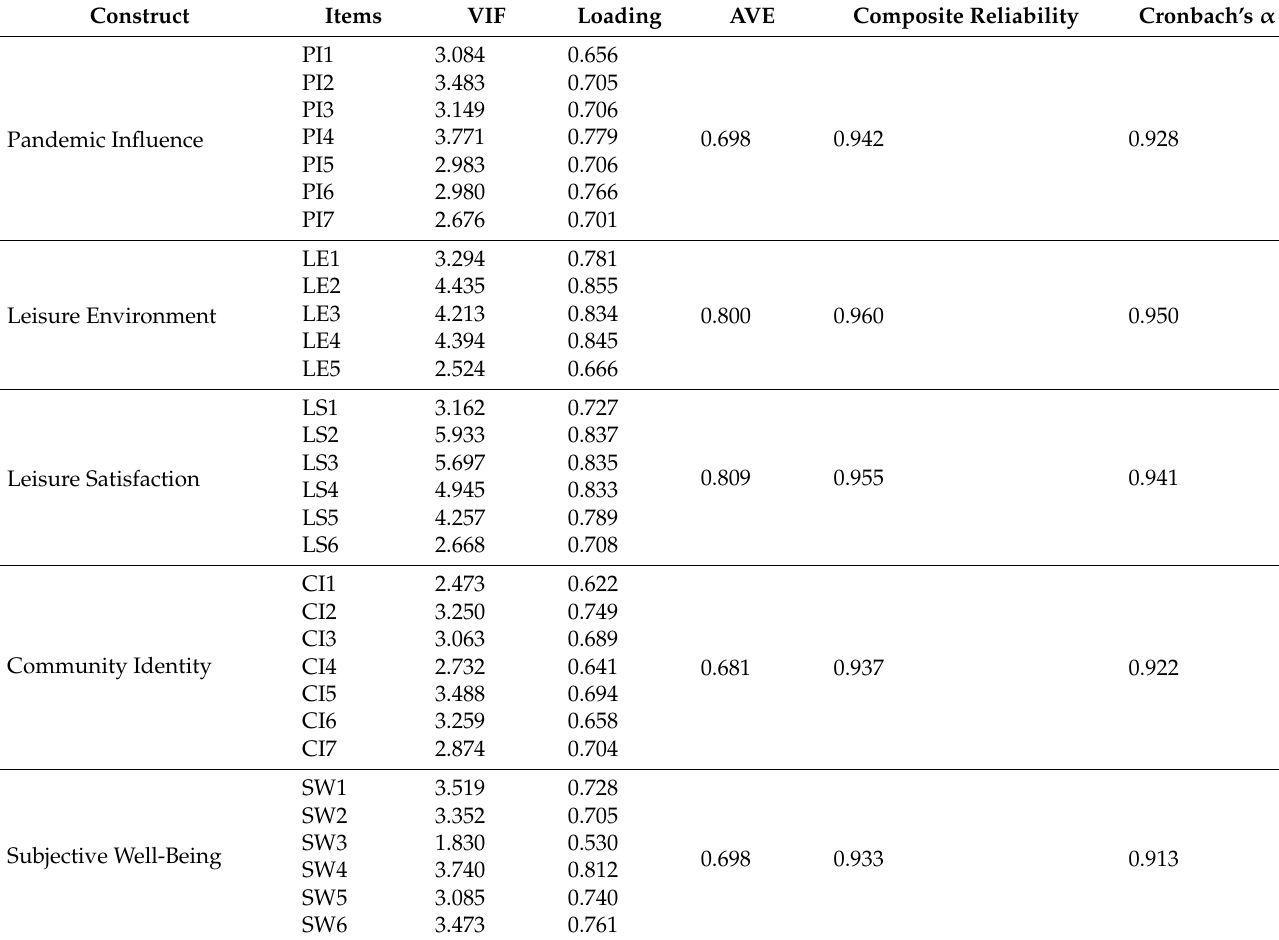
Table 3. The validity and reliability of the constructs.